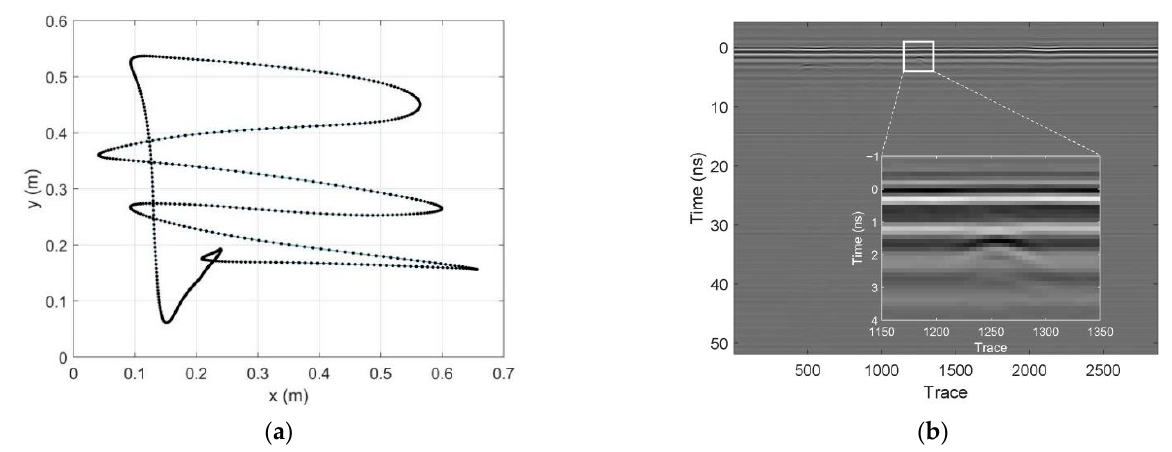
Figure 2. The data acquisition of ALIS. ( a ) Survey line and measurement points of GPR. ( b ) Original raw data of ALIS.